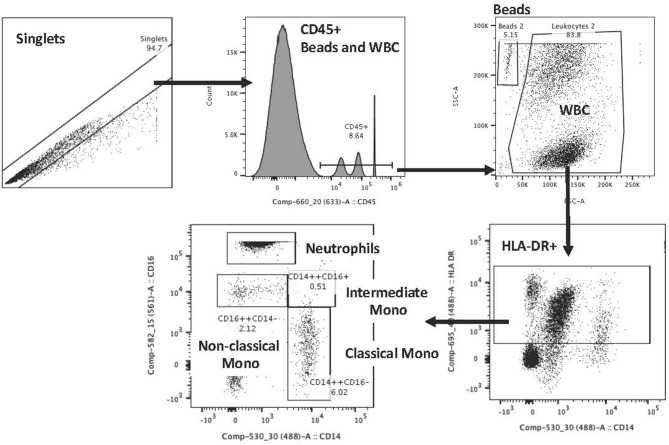
Flow cytometry gating scheme for monocyte evaluations.